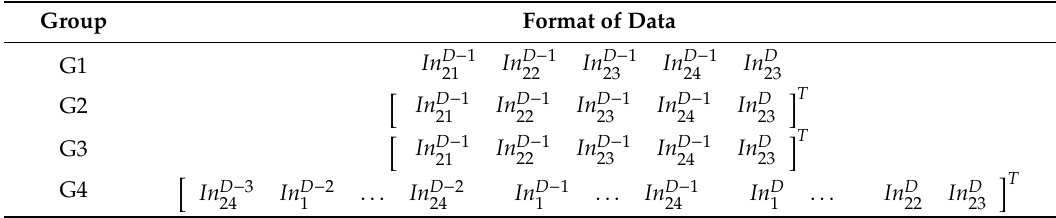
Table 4. Input data format.